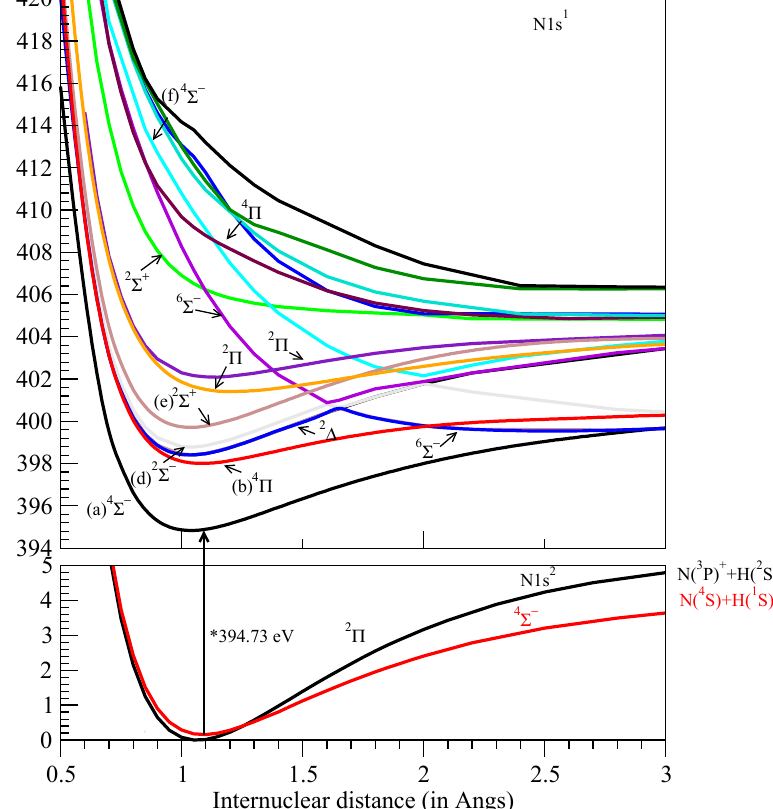
Figure 2. Multiconfiguration Self-Consistent Field (MCSCF) N1s 2 doublet 2 Π and quartet 4 Σ − ground states (lower panel) and low-lying configuration interaction single and double substitutions (CI-SD) N1s 1 nitrogen K-shell (upper panel) potential energy curves of the NH + molecular ion. * The bottom of the lowest N1s − 1 4 Σ − potential energy curve is set to the vertical density functional theory (DFT) energy transition of 394.73 eV represented by the vertical arrow (see text).